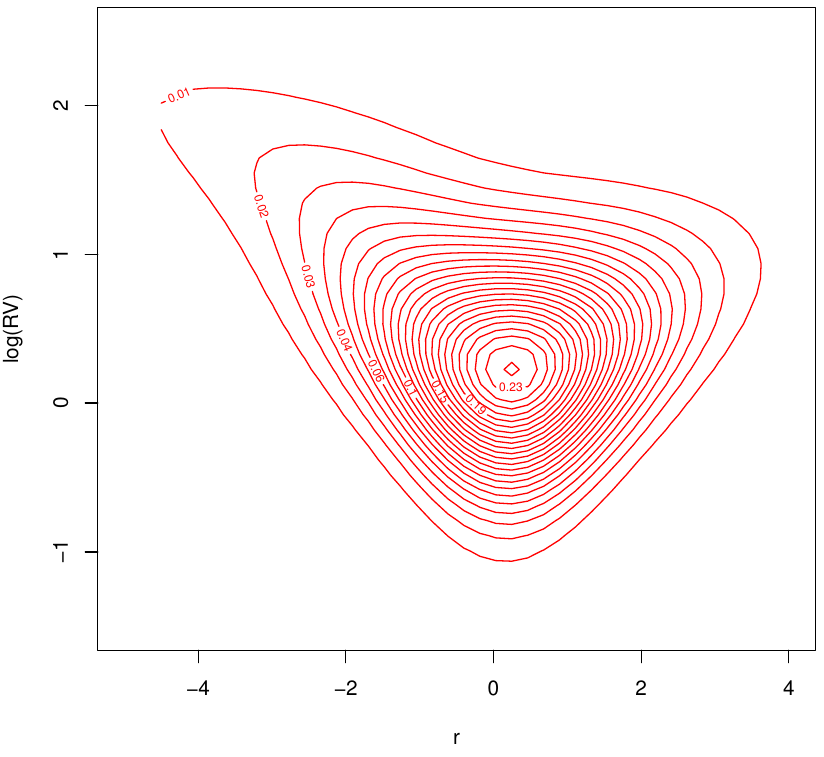
Figure 16. Predictive density for r ,log ( RV ) for high volatility I t − 1 , t = 2008 :